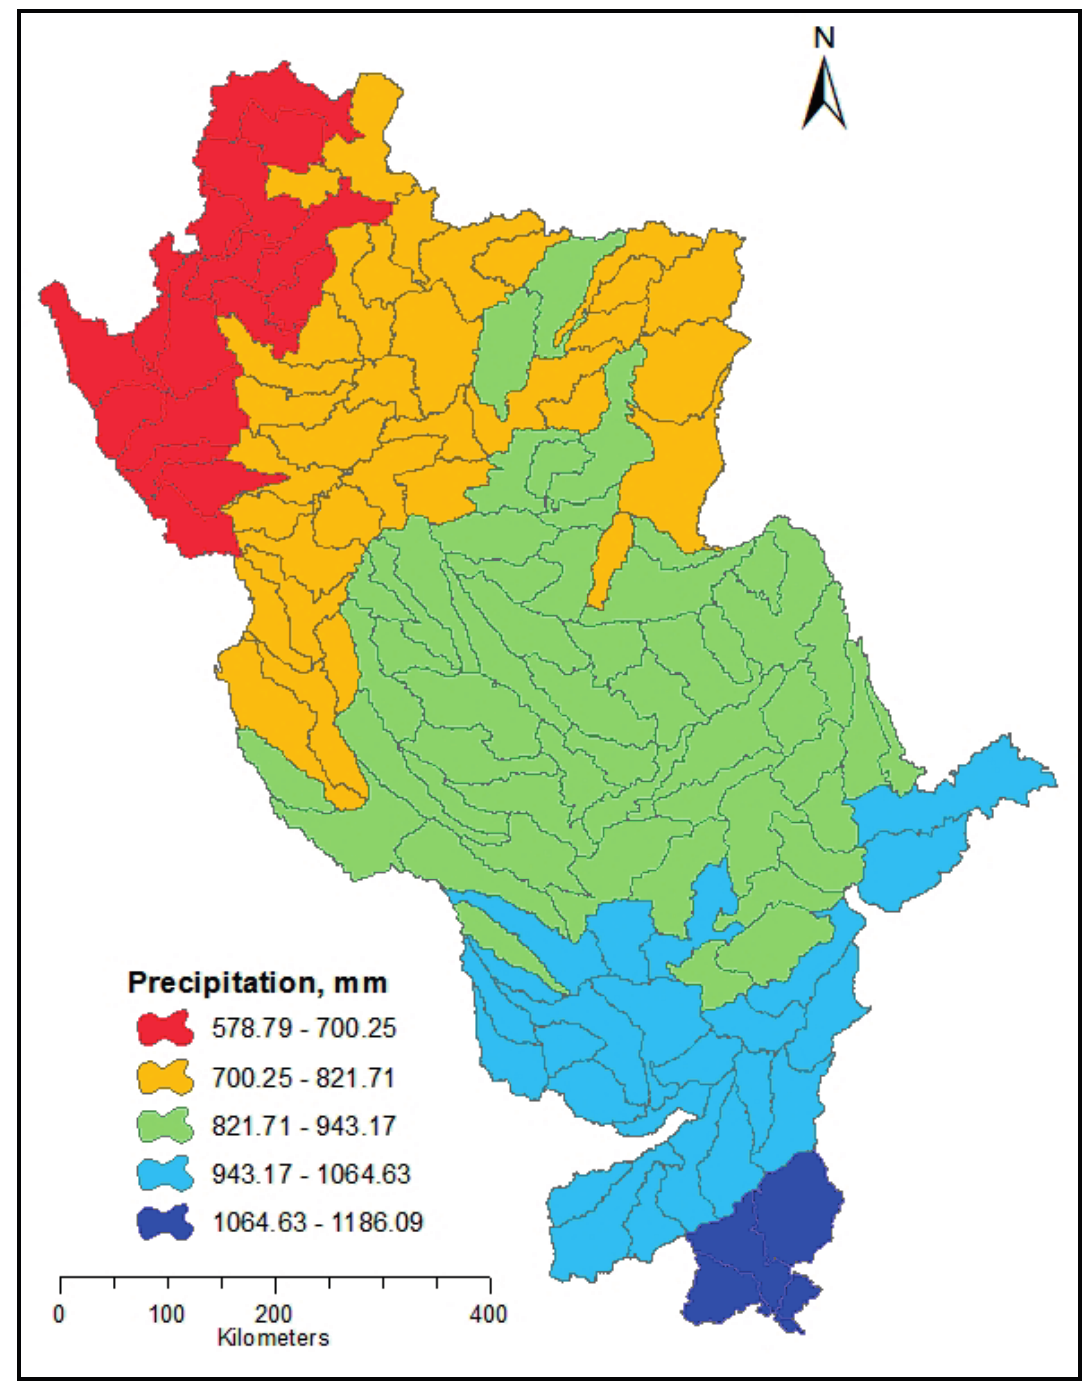
Figure 3. Spatial Variation of annual average precipitation (over 1960–2001) across UMRB